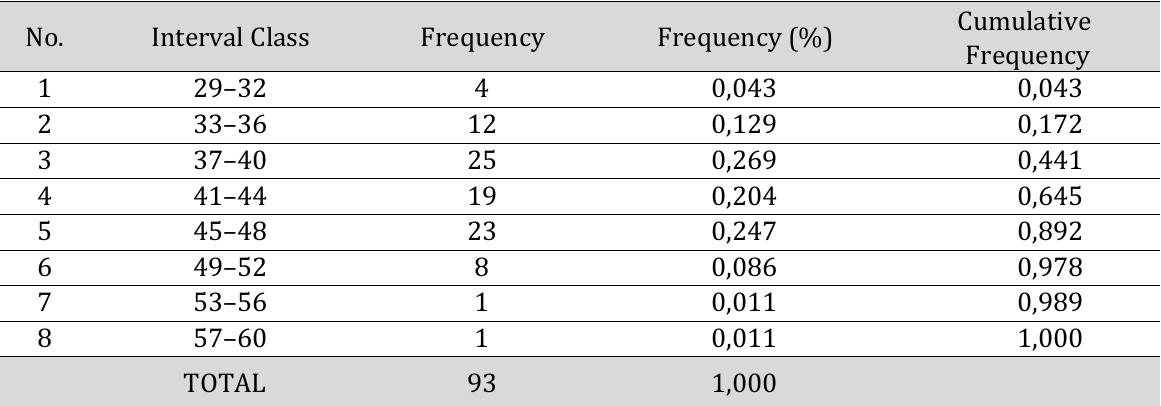
Table 10. frequency distribution of the scores of the teacher's oral feedback (indicator of feedback